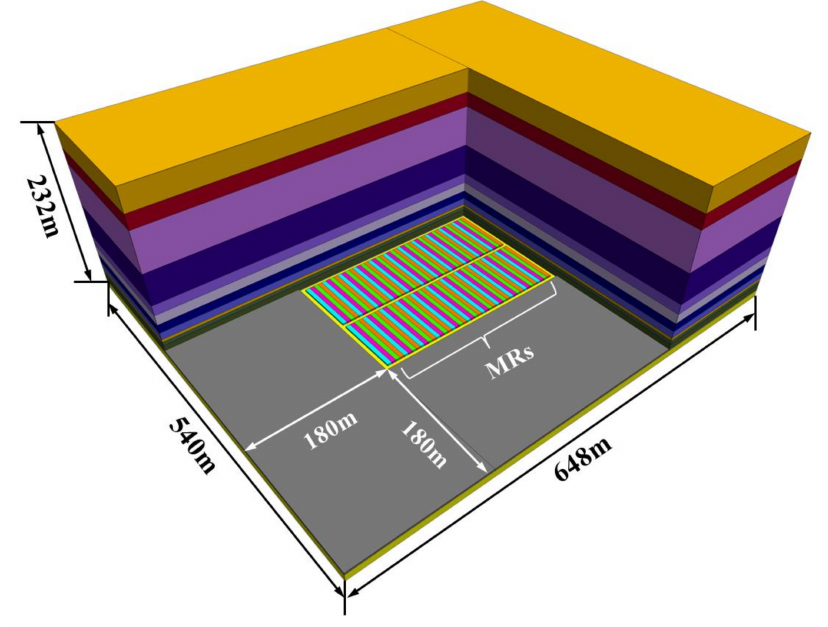
Figure 11. Numerical model and panel